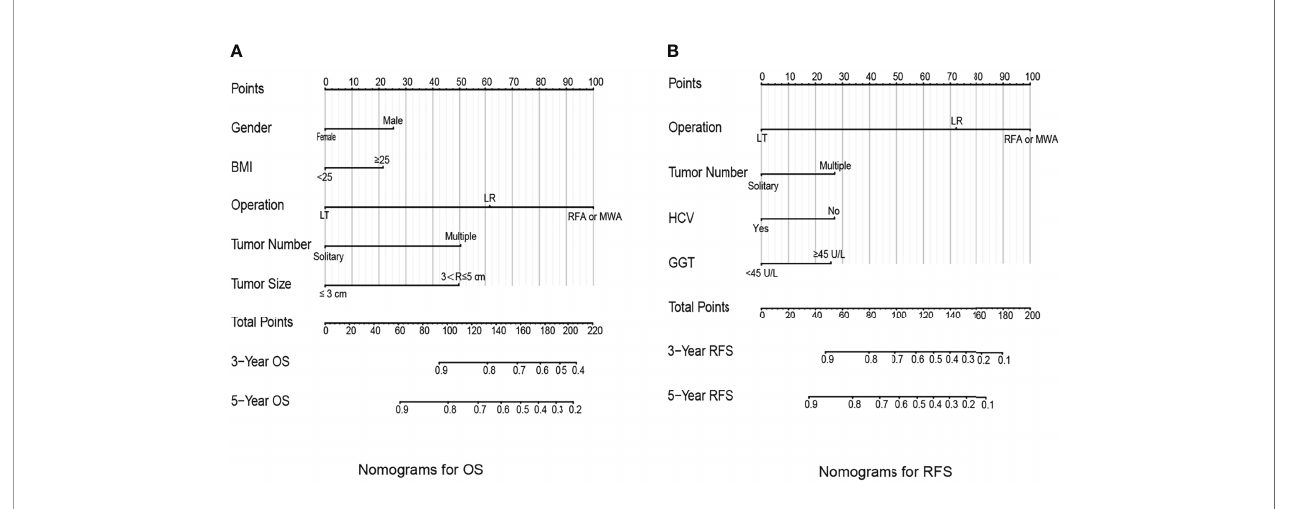
FIGURE 1 | Prognostic nomograms to predict the overall survival (A) and recurrence-free survival (B) of hepatocellular carcinoma